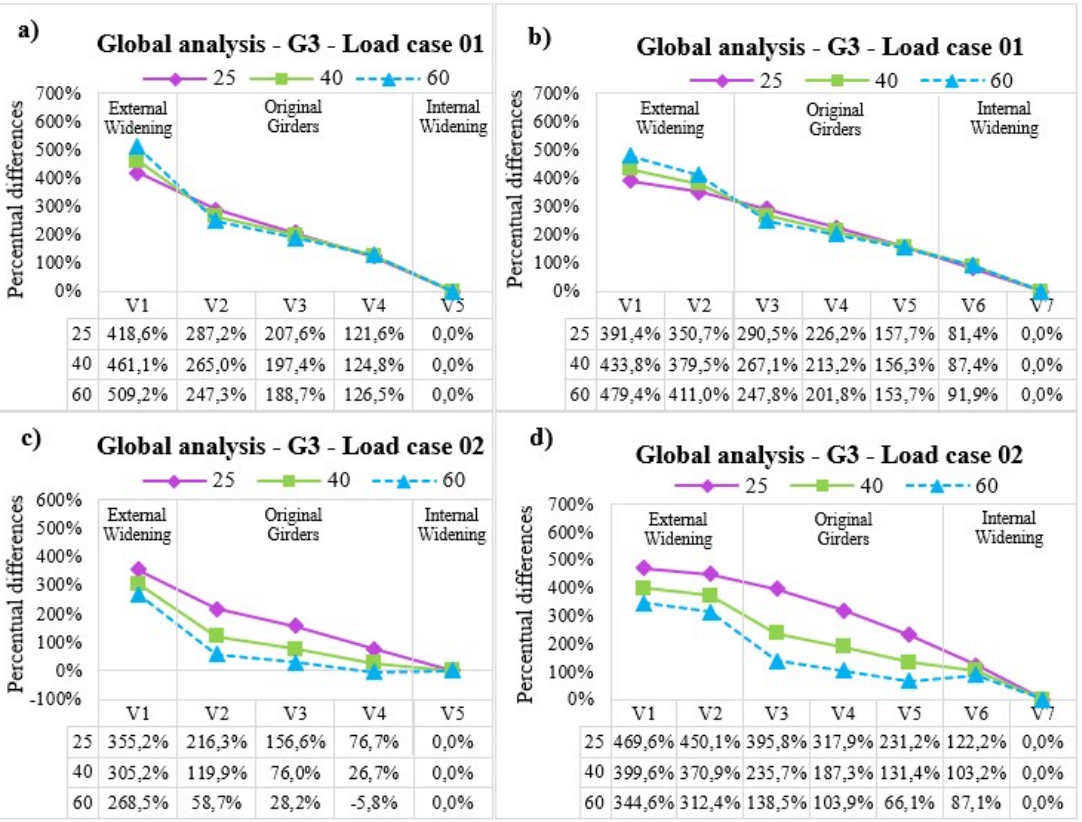
Figure 11. Global analysis of the BMDF's for the models with 25, 40, and 60 MPa widening, in comparison to the innermost girder: (a) 5L-G3 (Load case 01); (b) 7L-G3 (Load case 01); (c) 5L-G3 (Load case 02); (d) 7L-G3 (Load case